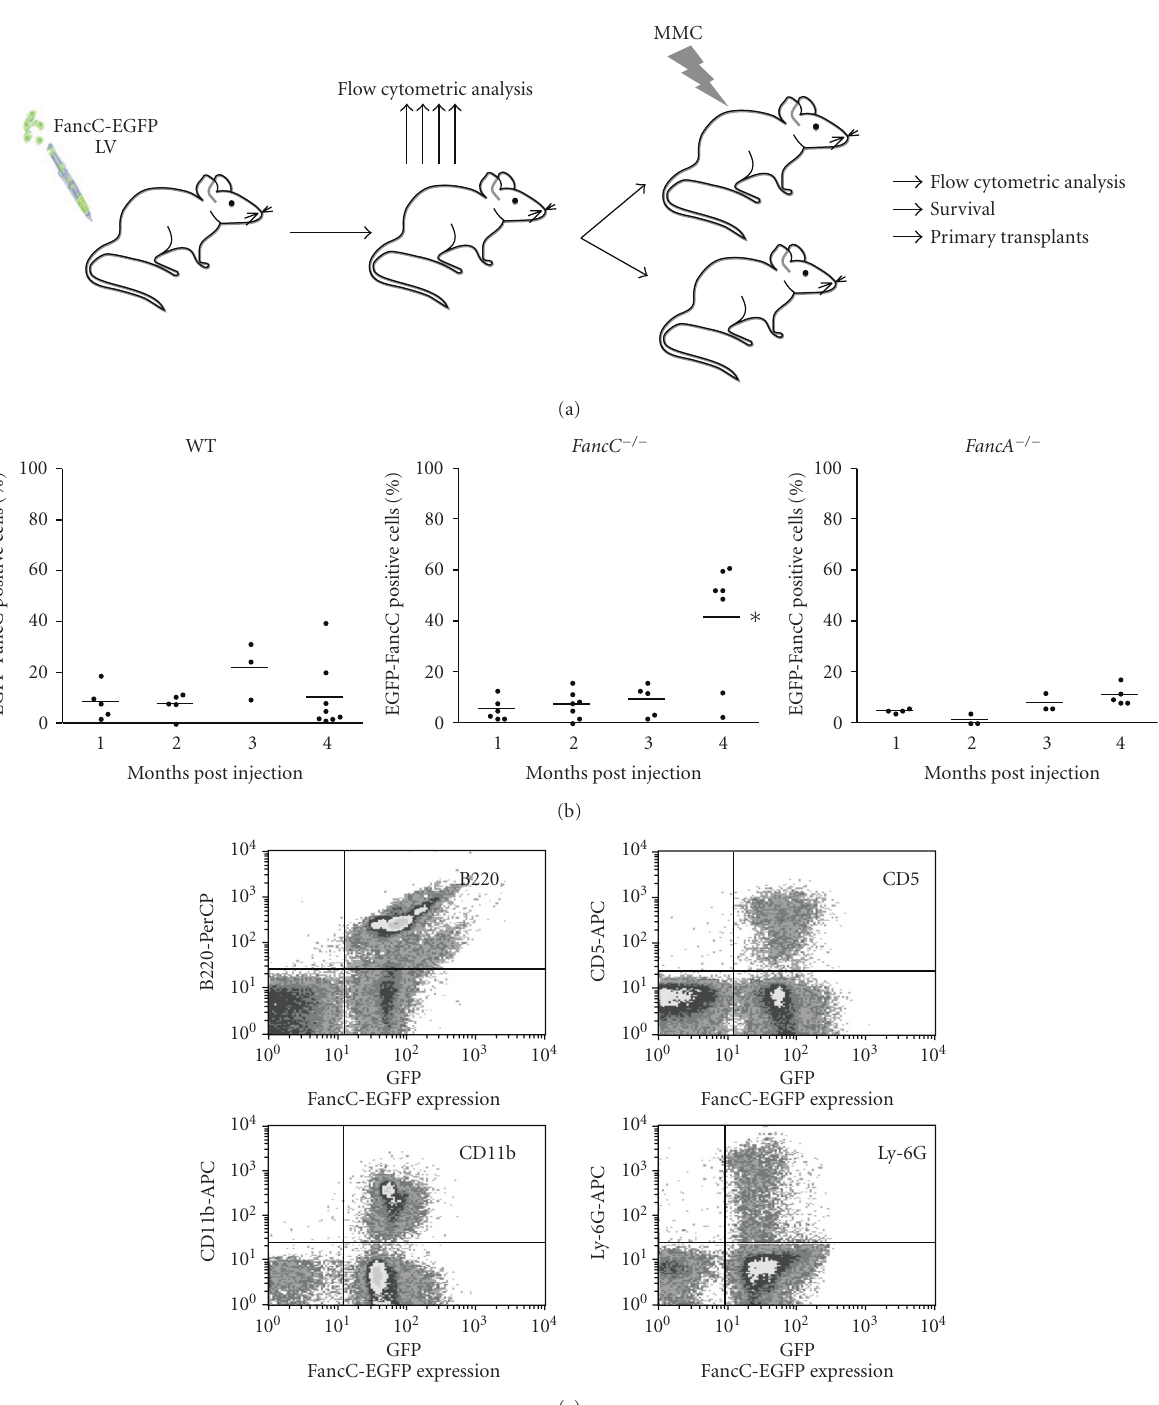
Figure 2: Intrafemoral gene transfer into BM of FA mutant mice. (a) Illustration of the experimental protocol used to determine the corrective potential of intrafemoral LV-mediated gene transfer into BM cells. Wild type (WT), FancC − / − and FancA − / − mice were intrafemorally injected with recombinant FancC-EGFP lentiviral particles. Transgene expression was monitored each month for at least four months. At 7 weeks following IF injections, each group of mice was divided where half of the mice were treated with MMC for 15 weeks (weakly injection of 0.3 mg/kg). (b) FancC-EGFP transgene expression in peripheral blood cells of IF injected WT, FancC − / − , and FancA − / − mice as a function of time. Each dot represents the FancC-EGFP expression of an individual IF-injected mouse. Horizontal line: mean value. ∗ P < . 02. (c) Representative FACS profiles of FancC-EGFP expression in FancC − / − peripheral blood cell lineages at four months after IF